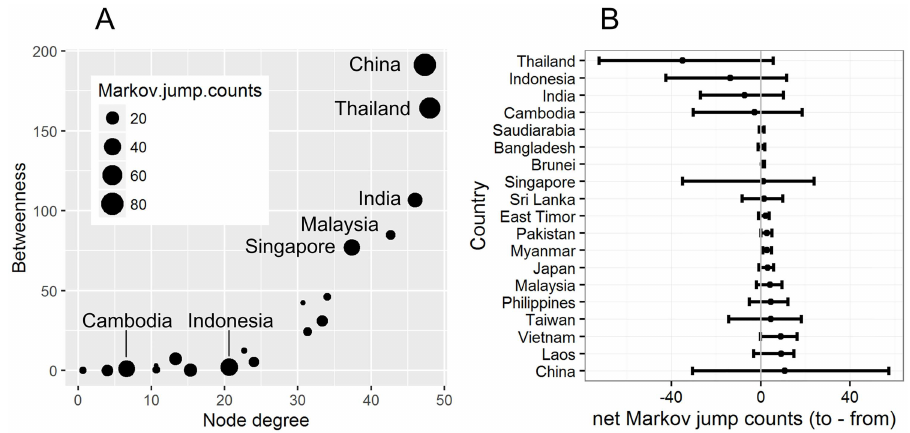
Fig 6. Centrality measures of the air passenger network and number of state transitions. (A) Scatterplot of centrality measures for the air travel network basedon degreeand betweenness. The “degree” centrality of a given country (node) refers to the number of airlineslinkingit in the airlinenetwork, and the “betweenness” centrality of a given country measures the extent to which a country lies on routes between other countries in airlinenetwork (see Methods). The size of each point correspondsto the numberof expectedMarkov jump transitions(includingboth importations and exportations). (B) Net Markov jump counts, summed across all 3 DENV serotypes. For each country, we summarize the averagenet Markov jumps (jumps to—jumps from) and their 95% credibleintervals. The estimates are orderedfrom the lowest to highestnumber of net